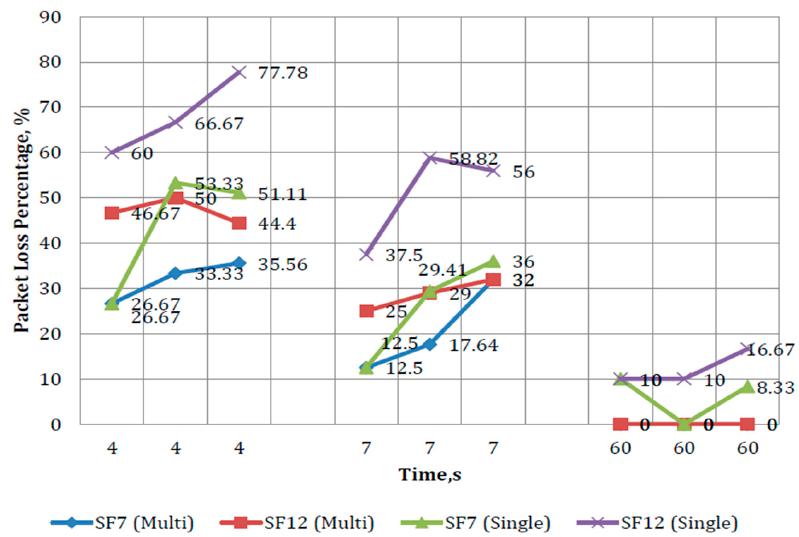
Figure 14. Performance comparison between the LoRaWAN ® multi-channel and single-channel GWs.